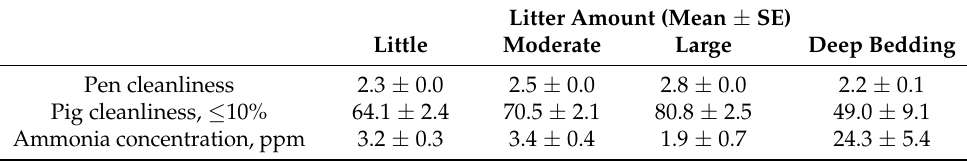
Table 6. Effect of litter amount on pen, pig cleanliness and ammonia concentration.